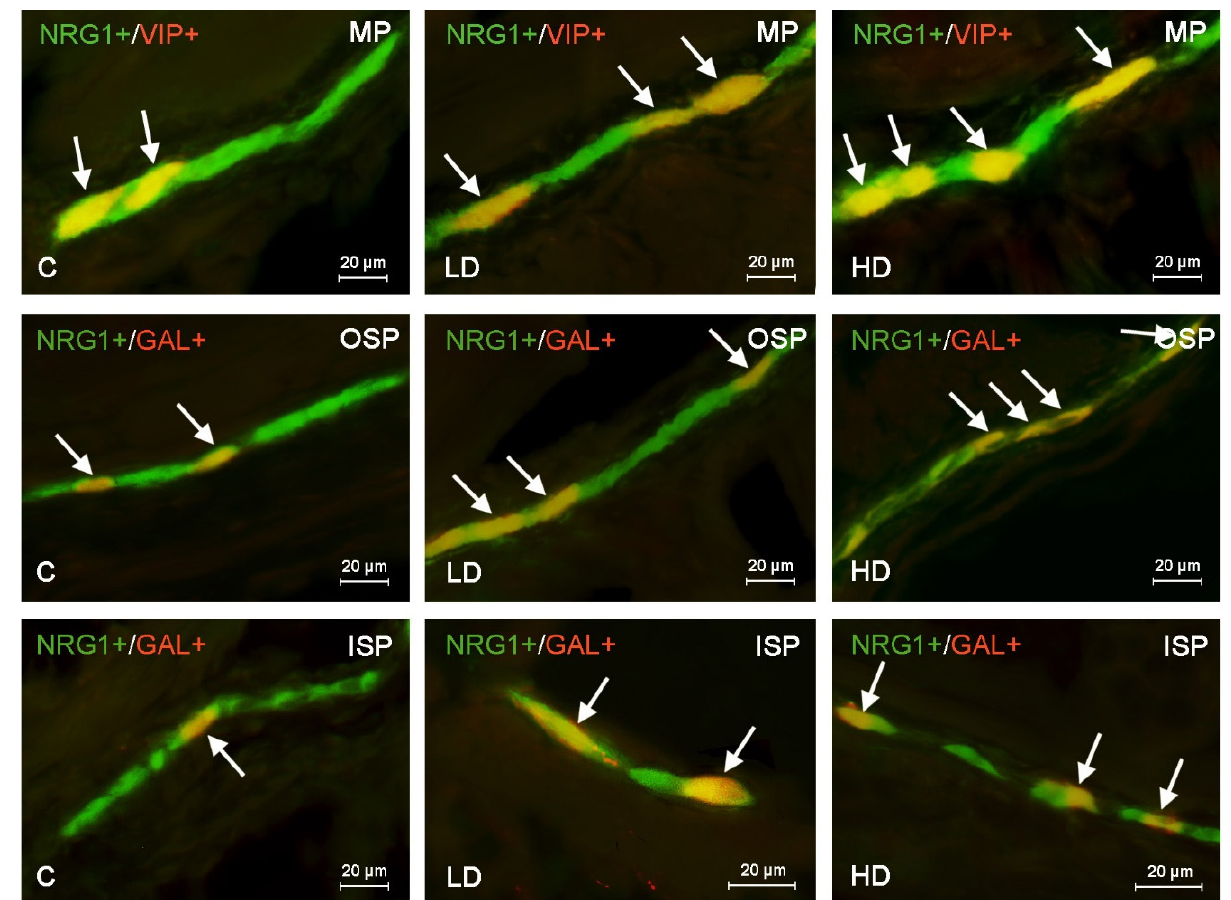
Figure 3. Distribution pattern of nerve cells immunoreactive to Neuregulin 1 (NRG1) and other neuronal substances studied—galanin (GAL), substance P (SP) or vasoactive intestinal polypeptide (VIP)—in the muscular plexus (MP), outer submucous plexus (OSP) or inner submucous plexus (ISP) in the porcine descending colon under physiological conditions (C) and in the low dose (LD) group and the high dose (HD) group. The pictures are the result of the overlap of both stainings. Neurons immunoreactive for both NRG1 and other of the neuronal substances studied are indicated with